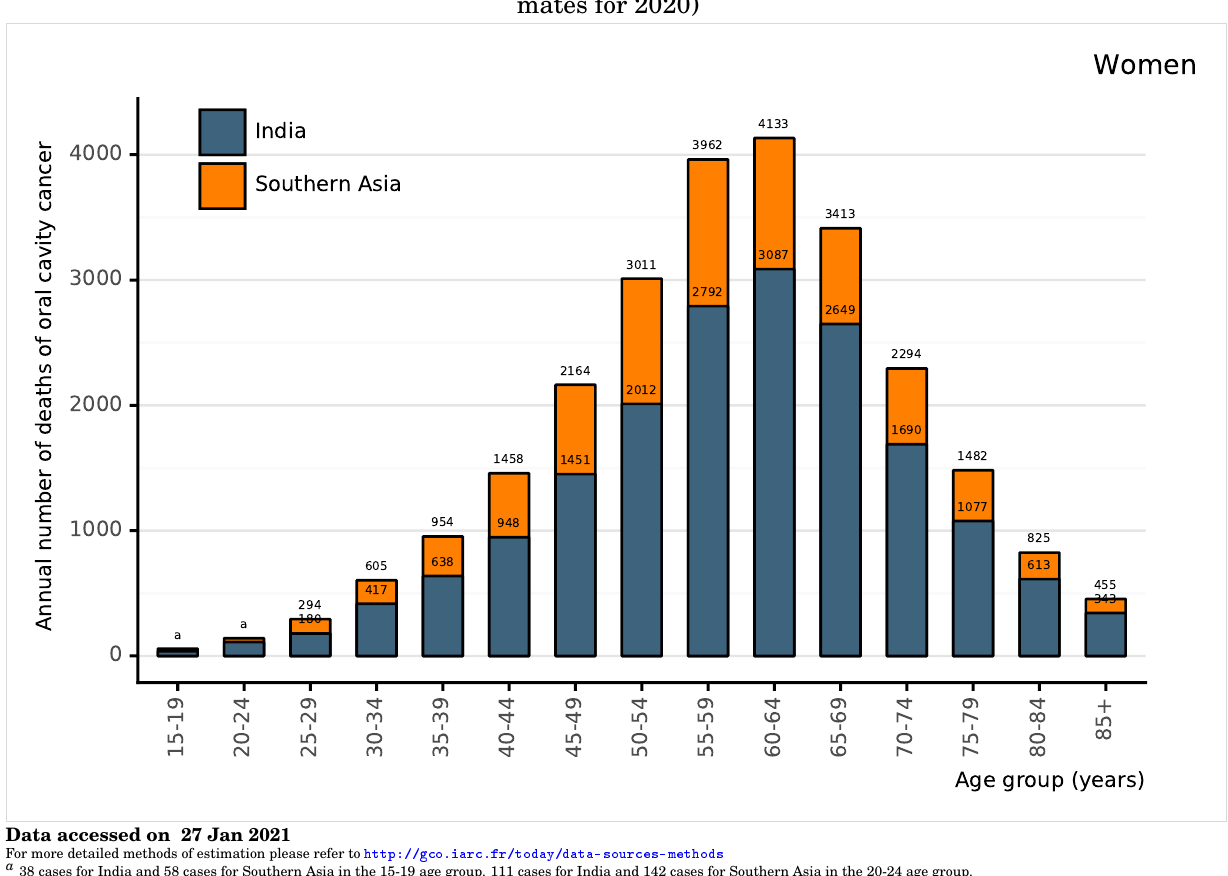
Figure 129: Annual number of deaths of oral cavity cancer among women by age group in India